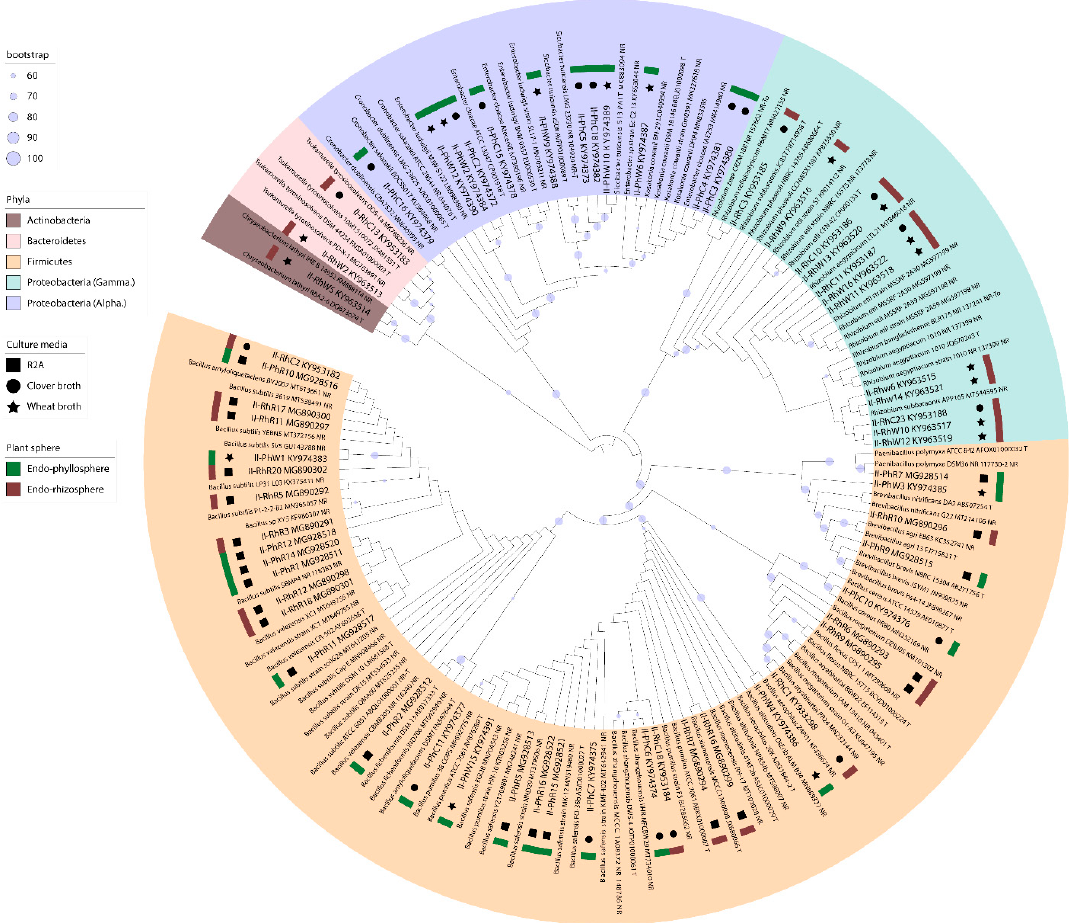
Figure 4. Circular phylogenetic tree based on the 16S rRNA gene sequences of 62 bacterial isolates representing endophytes of clover phyllospheres and rhizospheres. Plant broth-based culture media supported greater diversity of clover endophytes. The phylogenetic tree was constructed using Maximum Likelihood and assumes the Jukes–Cantor model of nucleotide substitution. The tree is annotated with taxonomy at phylum-level (background colour), plant sphere (coloured strip) and culture media of isolation (different symbols). Codes of isolates are indicated in bold and succeeded by their accession numbers; closest matches obtained from the GenBank database are also indicated by the organism name and accession numbers.